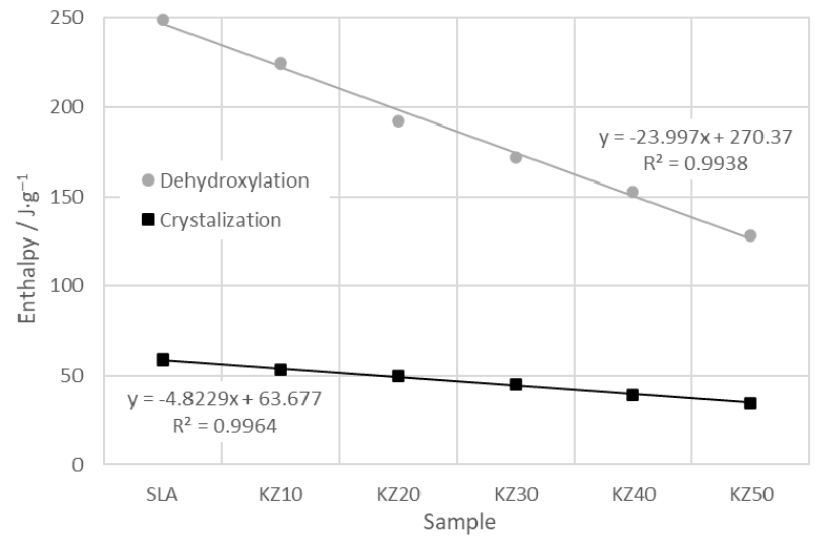
Figure 3. The enthalpy of the studied samples during the dehydroxylation of kaolinite (grey) and crystallization of spinel (black).